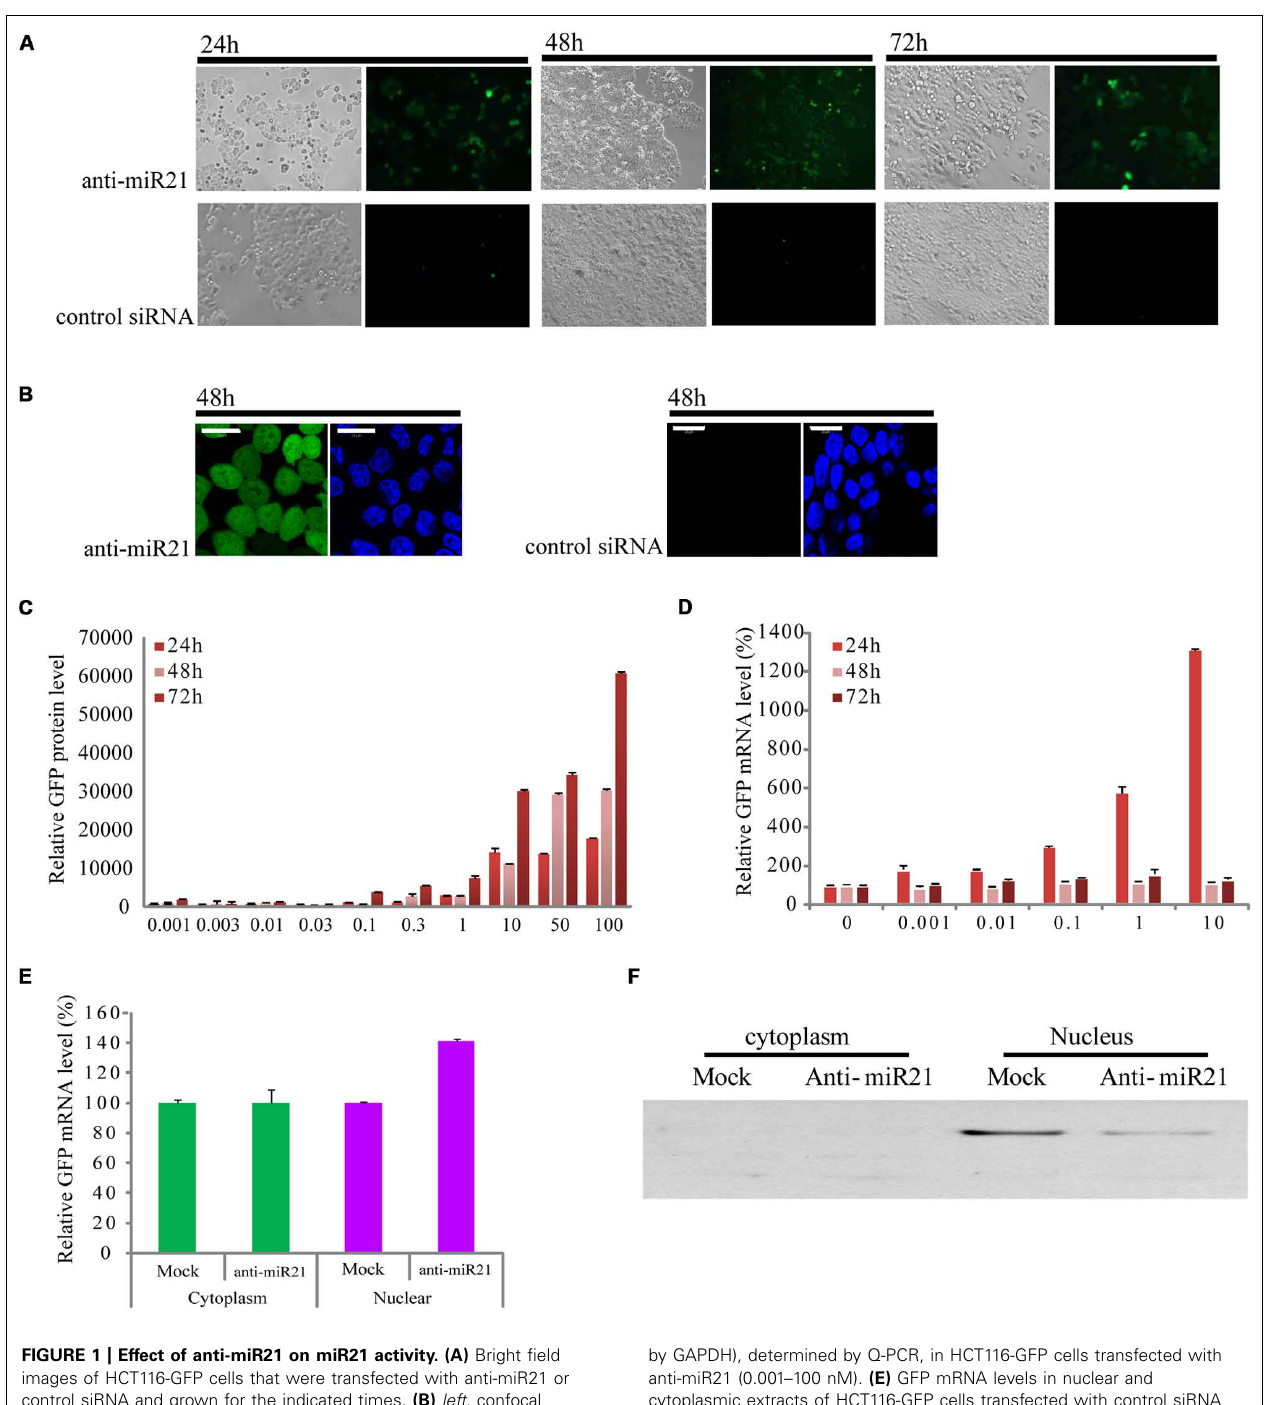
by GAPDH), determined by Q-PCR, in HCT116-GFP cells transfected with anti-miR21 (0.001–100 nM). (E) GFP mRNA levels in nuclear and cytoplasmic extracts of HCT116-GFP cells transfected with control siRNA and anti-miR21. MiRNA levels were determined as described in (D) . (F) Confirmation of separation of nuclear and cytoplasmic fractions. Aliquots containing 30 μ g of total protein from cytoplasm and nuclear extracts were separated by 12% SDS-PAGE gel, transferred onto nitrocellulose membrane, and probed with antibodies specific for the nuclear protein